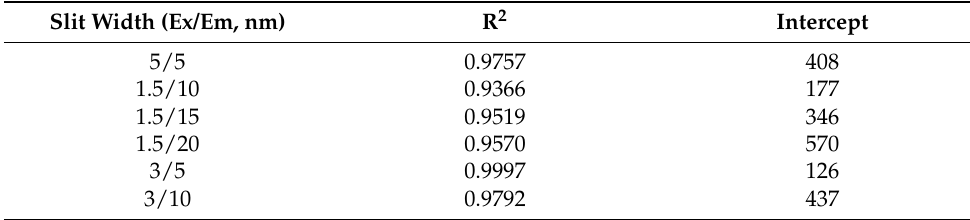
Table 1. Effect of slit width on the linear characteristics of the series DBP solution.